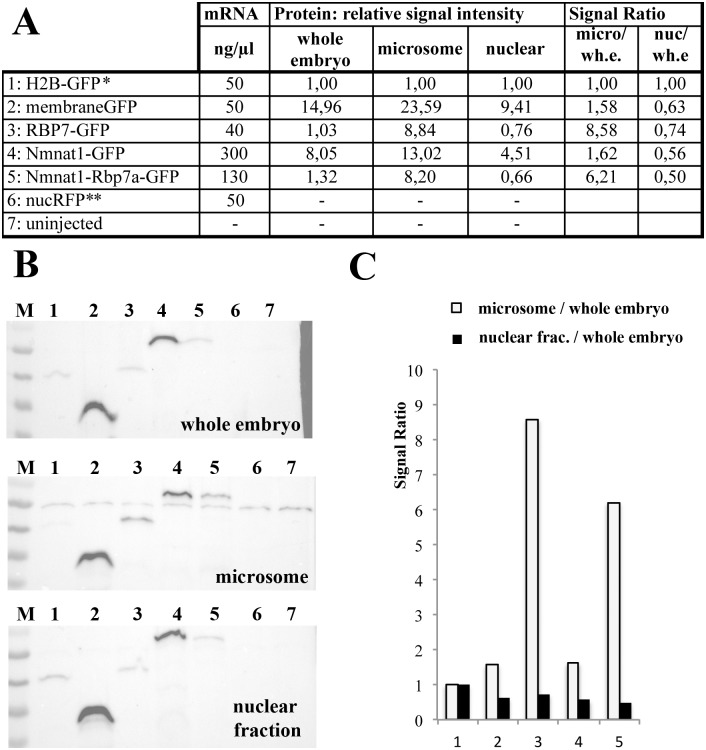
Rbp7a-GFP and Nmnat1-Rbp7a-GFP are enriched in microsome preparation.[A] Experimental overview indicating the encoded proteins, concentrations of injected mRNA (2nl/embryo) and data quantification of Western-Blot shown in [B]. Relative signal intensities always relate to H2B-GFP signals (*). Signal ratios correspond to the indicated quotient of t relative signal intensities. All mRNA were co-injected with 50ng/μl nucRFP mRNA (**). [B] Anti-GFP based Western-Blot analyses of whole embryo extracts (~1,7 embryos/lane), microsome preparation (~7,5 embryos/lane) and nuclear extracts (~1,5 embryos/lane). [C] Diagram showing indicated relative signal ratios shown in [A].